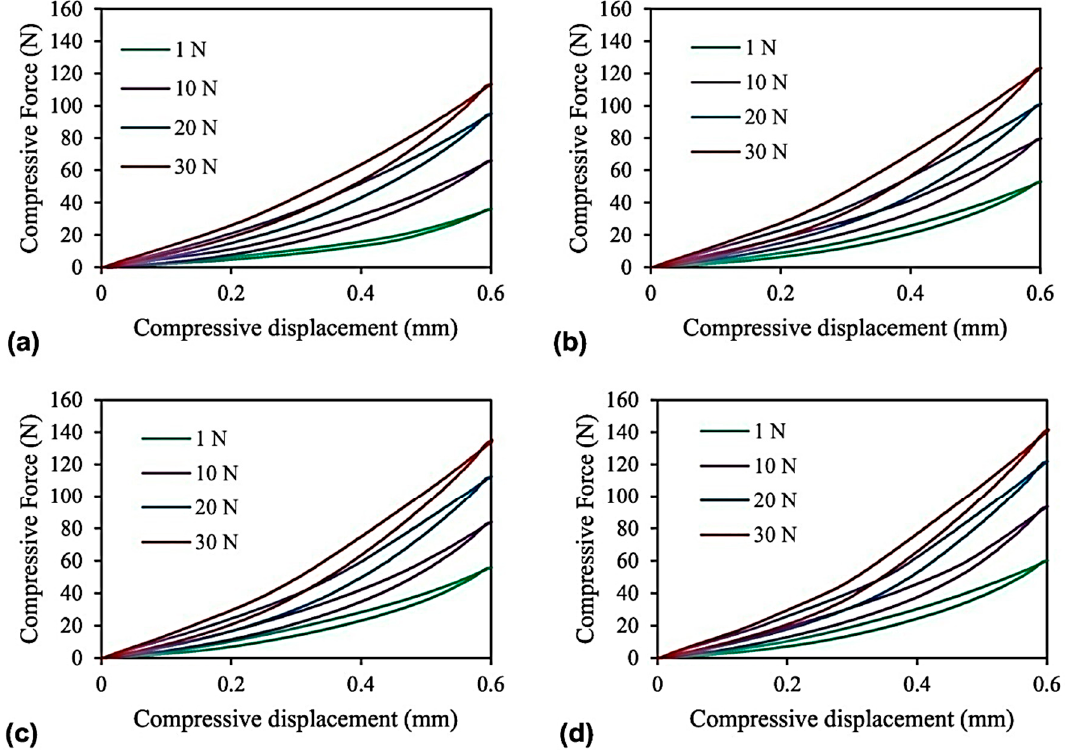
Figure 10. The plot of compressive force–cyclic compressive displacement under the conditions of constant peak-to-peak displacement (0.6 mm), constant frequency (0.1 Hz), various preloads, and various magnetic field strengths: ( a ) 0 mT, ( b ) 190 mT, ( c ) 320 mT, ( d ) 520 mT [89] (reprinted with permission from Elsevier TM ).